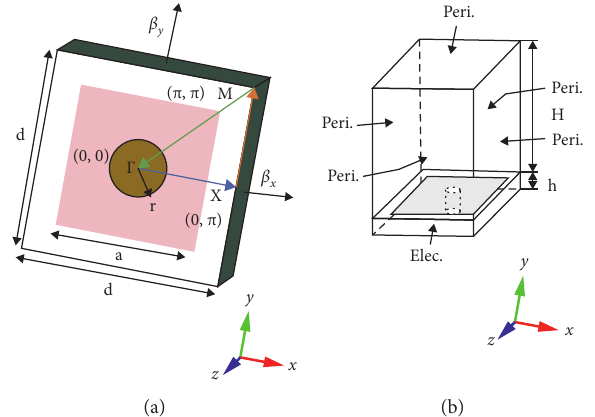
Figure 5: (a) Mushroom-type square EBG unit of size d � 2.8mm, consisting of a square patch with size a � 2.0mm, connected in the center to the ground by a via with radius r � 0.3mm. The points defining the path in the Brillouin zone are also indicated. (b) Boundary conditions in the